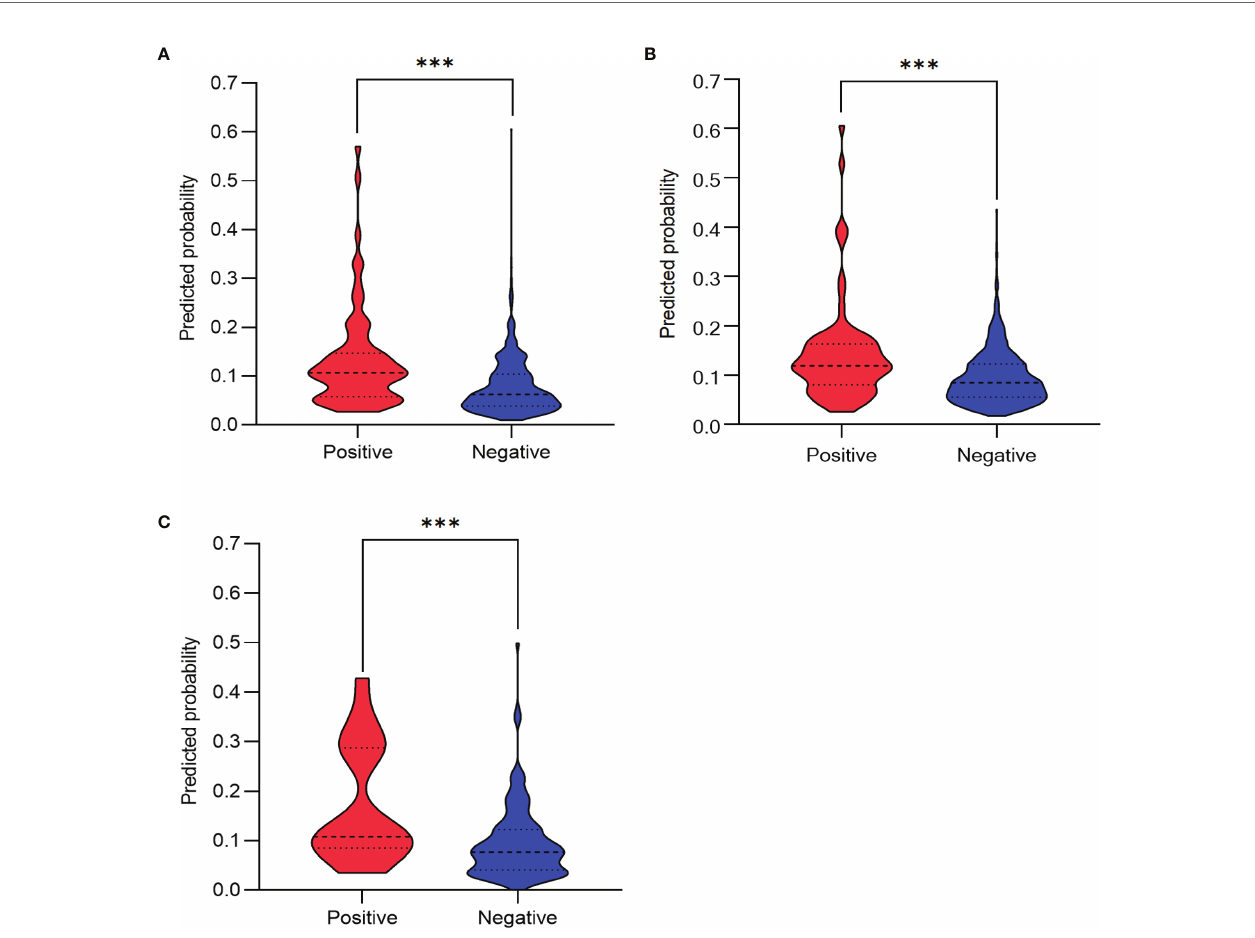
FIGURE 4 | Discrimination slope for the algorithm in the training group (A) , the internal validation group (B) , and the external validation dataset (C) . The violin plots were drawn with predicted probability of developing postoperative pneumonia against actual status (positive indicates patients with postoperative pneumonia; negative indicates patients without postoperative pneumonia). The discrimination slope was 0.06 (95%CI: 0.04-0.07, p < 0.001 ,Wilcoxon test) in the training group, 0.05 (95% CI: 0.03 – 0.06, p < 0.001, Wilcoxon test) in the internal validation group, and 0.08 (95% CI: 0.04 – 0.12, p < 0.001, Wilcoxon test) in the external validation dataset. ***P < 0.001.